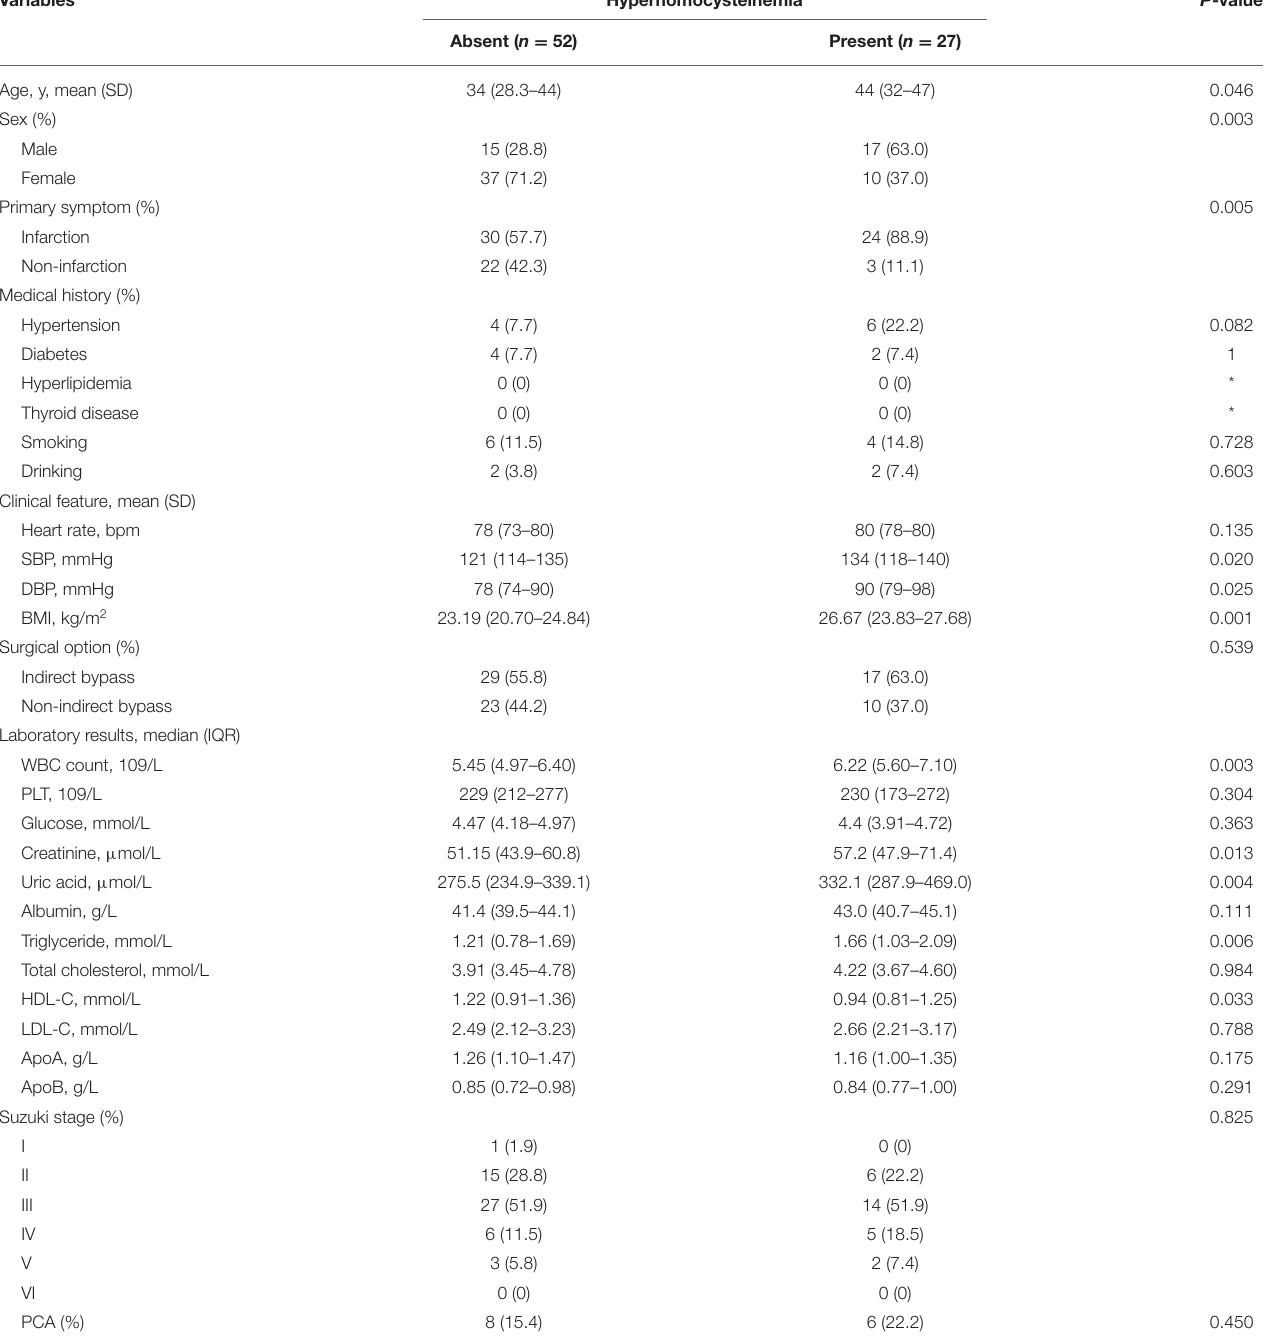
TABLE 2 | Clinical characteristics of patients according to hyperhomocysteinemia